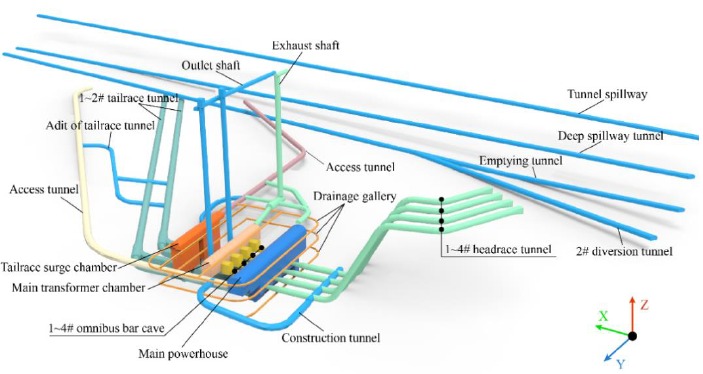
Figure 1. Layout of the caverns in the diversion and power generation system on the left bank of the Shuangjiangkou hydropower station [26].